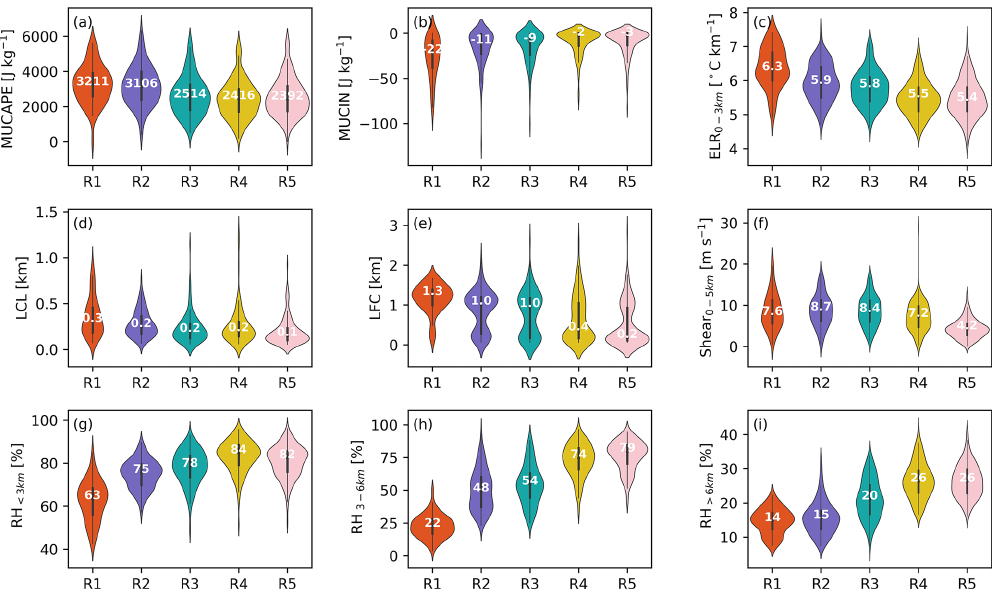
Figure 4. Shaded probability density plots for select thermodynamic quantities of interest estimated from the 12:00UTC radiosondes in each Amazon regime. The median values for each regime distribution are reported on each violin (white text). The interior black box shows the interquartile range and the thin black lines reflect the 95% confidence